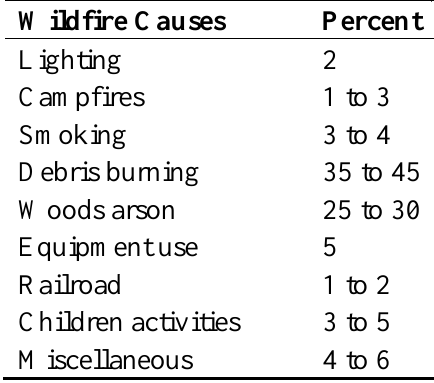
Table 1. Wildfires by cause in South Carolina